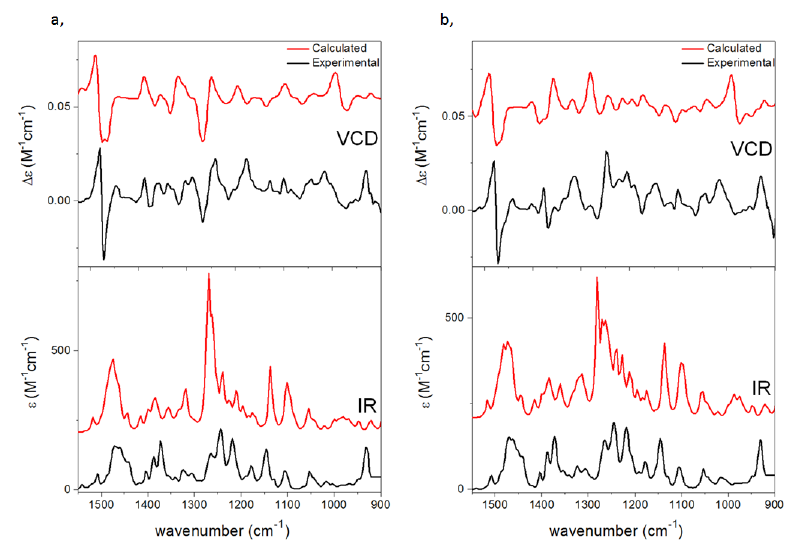
Figure 8. Experimental VCD (upper black, in CDCl 3 ) and IR spectra (lower black, in CDCl 3 ) of ( a ) (5 S ,1 ′ S ) ‐ 3a and ( b ) (5 S ,1 ′ R ) ‐ 3b compared with the B3LYP/TZPV PCM/CHCl 3 VCD (upper red) and IR (lower red) spectra.